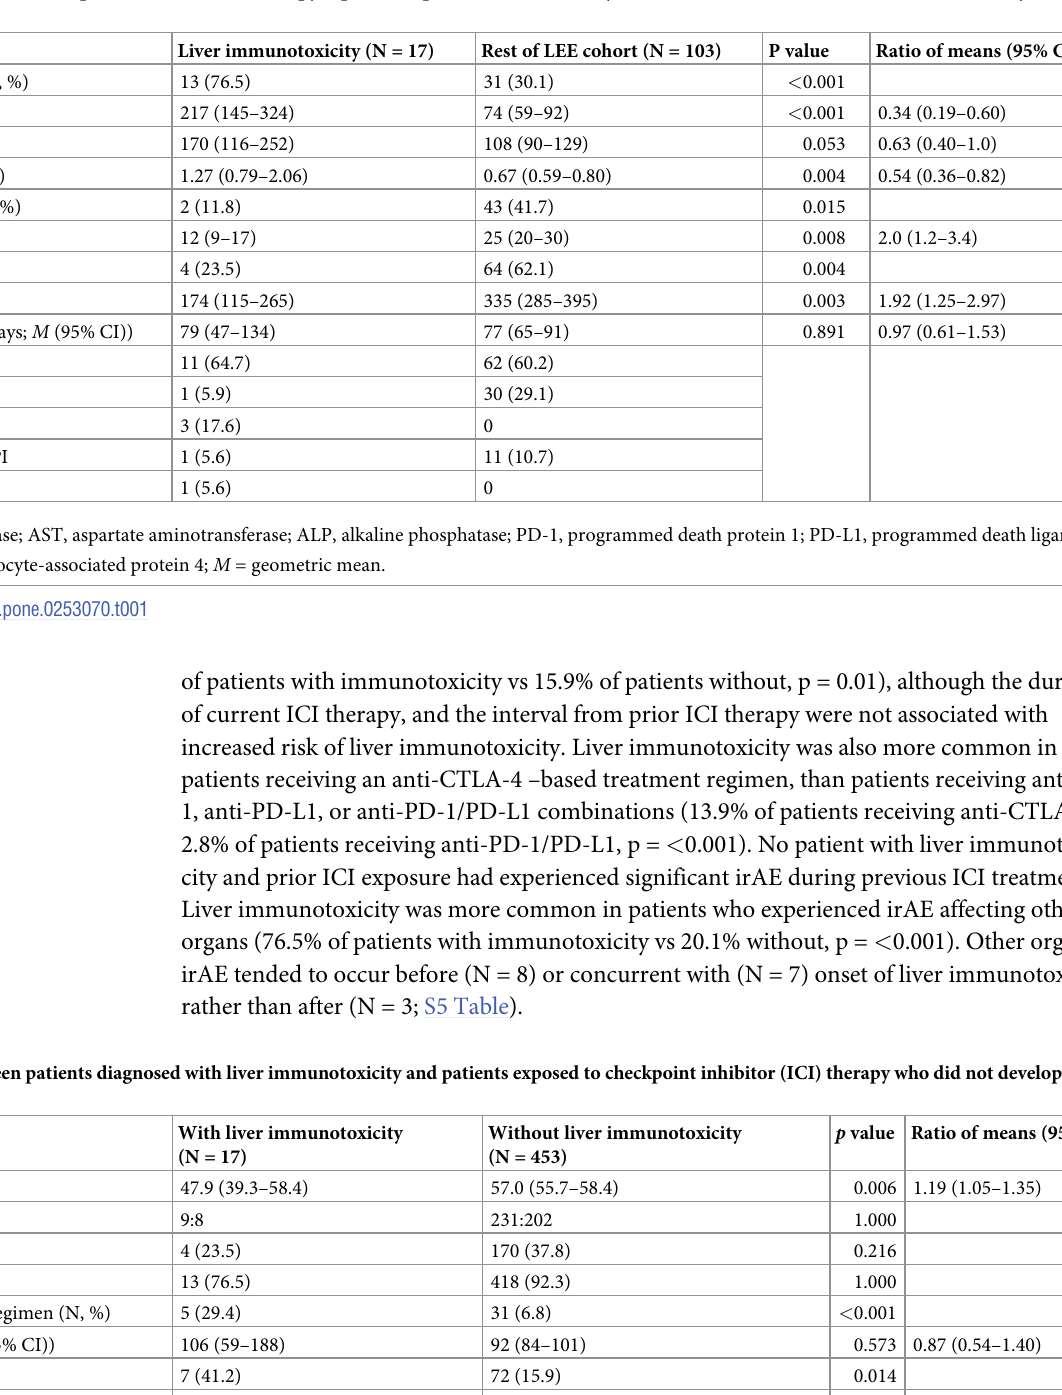
Table 1. Laboratory values and checkpoint inhibitor (ICI) therapy exposure in patients with liver enzyme elevations (LEE) attributed to immunotoxicity compared with other causes.